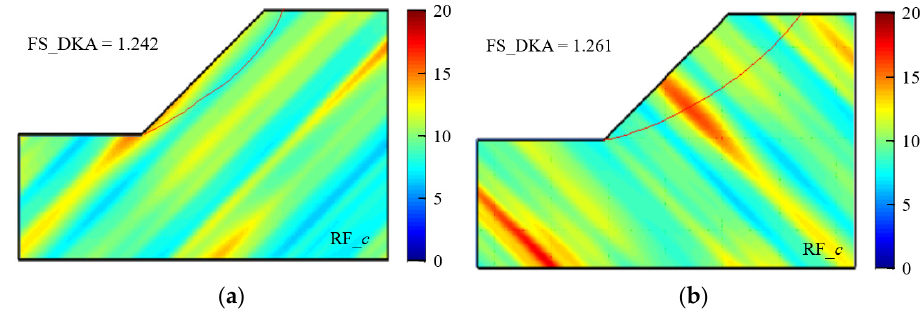
Figure 12. Comparison of the slip surface with different random field rotation angles. ( a ) β = 45°; ( b ) β = 135°.